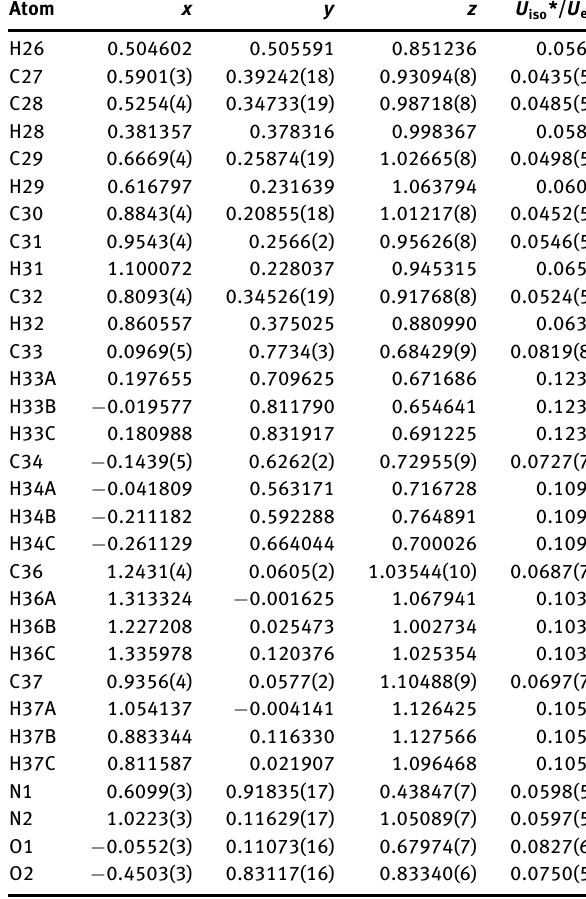
Table 2: Fractional atomic coordinates and isotropic or equivalent isotropic displacement parameters (Å 2